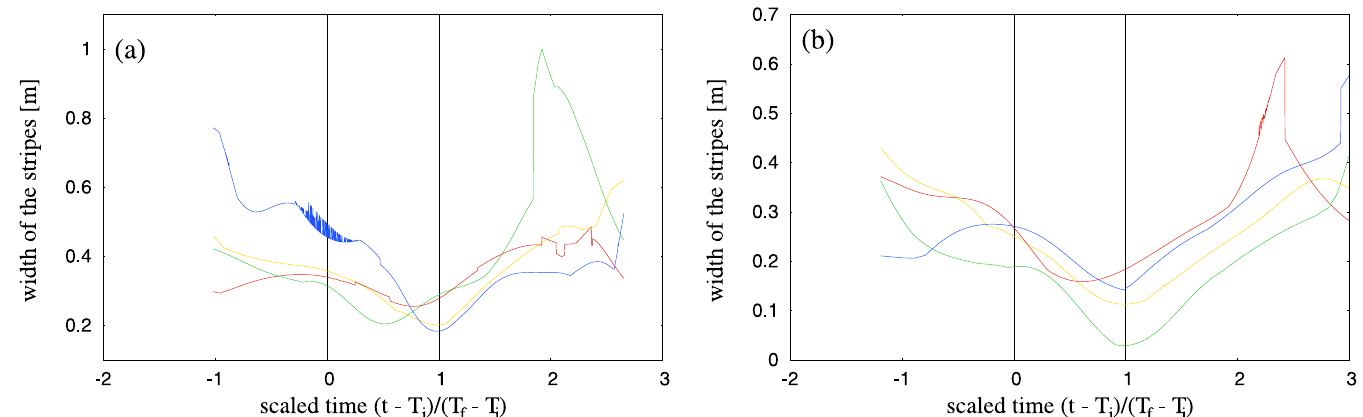
Fig 10. Width of stripes as a function of time. Figure shows variation of stripe width as a function of time for all the stripes from a trial for two typical trials with (a) α = 89.8˚ and (b) α = 116.9˚. Time t has been scaled as t ¼ t (cid:0) T i dashed lines in the figure. For almost all the cases, we see that the width of the stripe attains a global minimum within the interval 0 and 1, which represents the ‘squeezing’ of stripes.